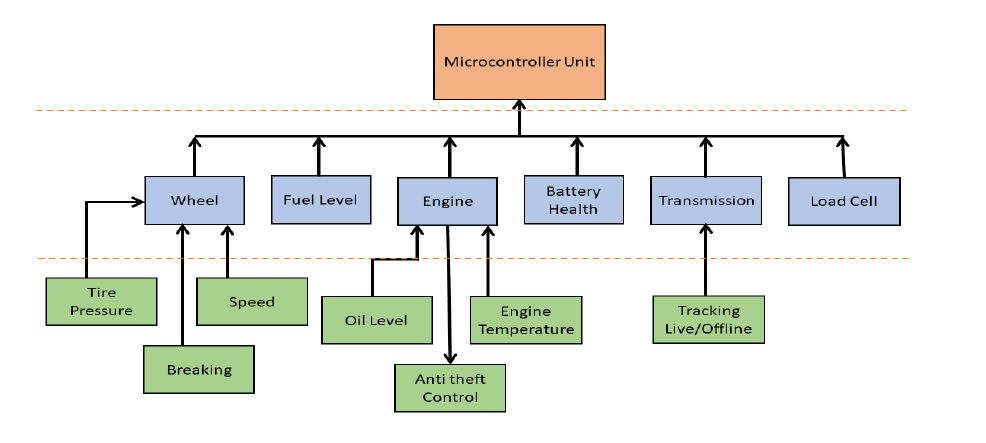
Figure 4 . Block diagram of the proposed model